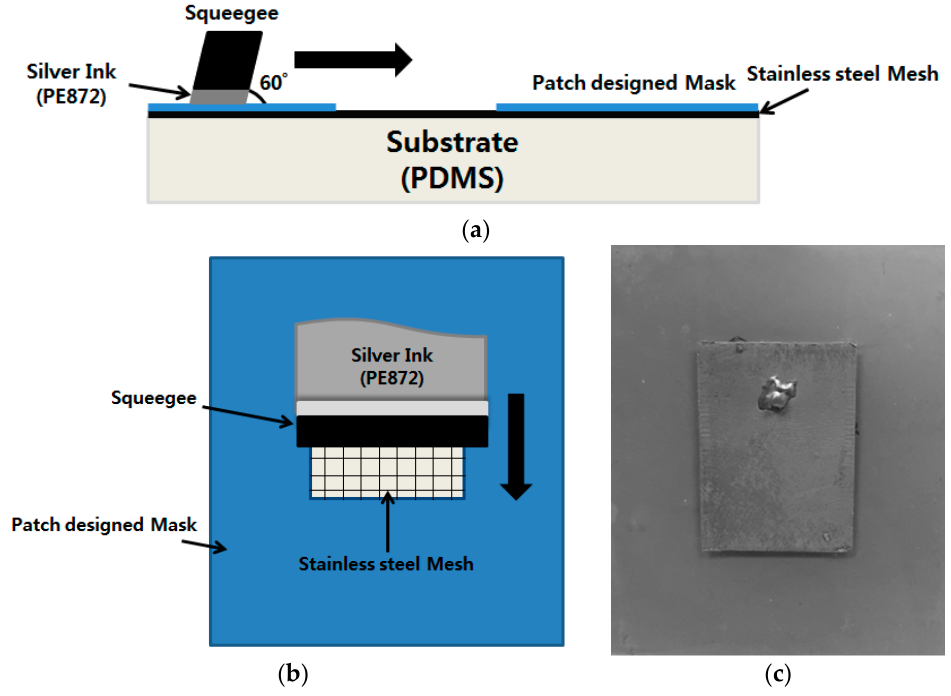
Figure 5. Silver screen printing process. ( a ) Screen printing process side view. ( b ) Screen printing process top view. ( c ) Picture of the fabricated prototype.